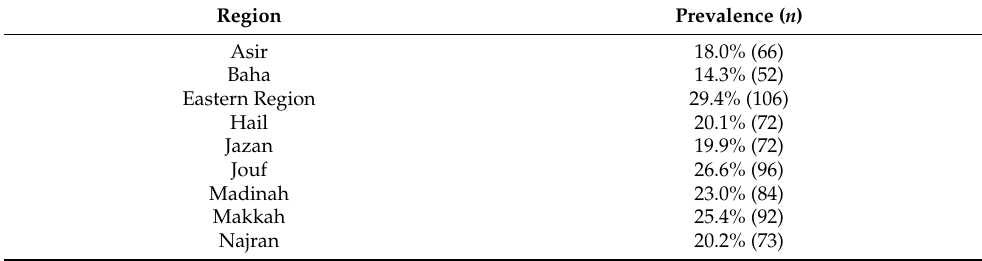
Table 2. Prevalence of obesity in the sample (BMI ≥ 30) prevalence by region, age group, and